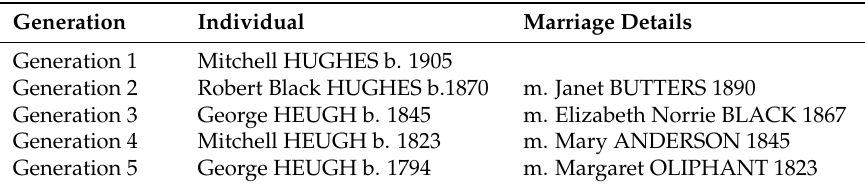
Table 1. First five